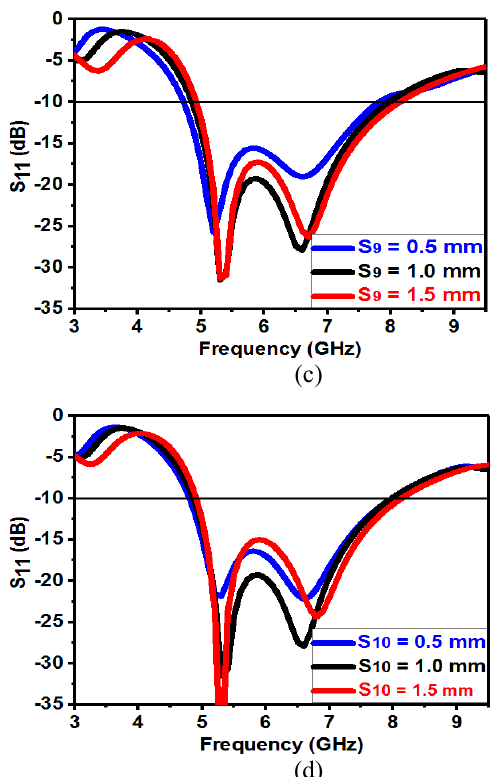
Figure 7. Parametric study for (a) S, (b) S 4, (c) S 9 and (d) S 10 The proposed design also exhibits good current distribution in the radiating patch as illustrated in Figure 8 (a), (b), (c) and (d) respectively. The portion of the antenna which is excited at a particular frequency band is encircled in black.